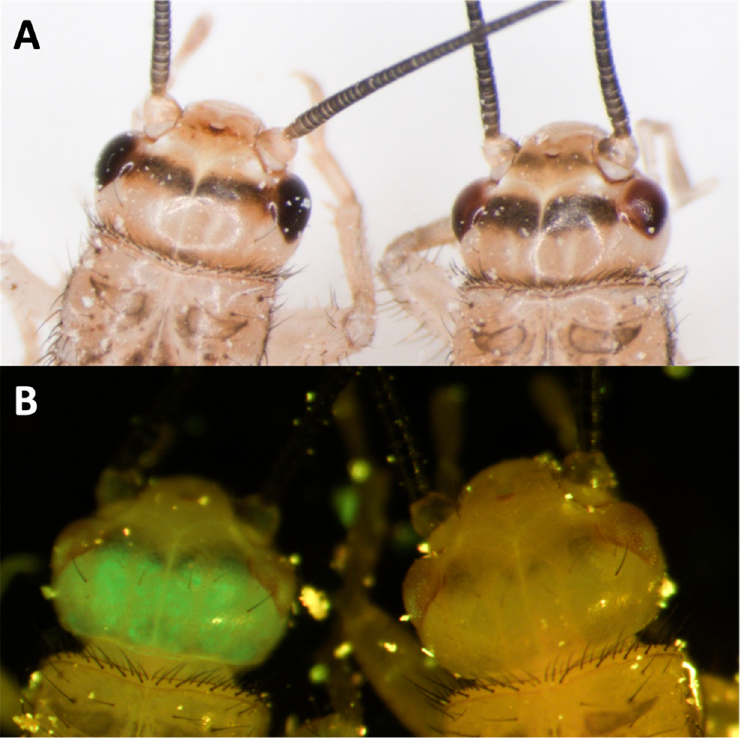
Figure 10. A. domesticus RNAi phenotypes. ( A ) Ad vermilion gene knock-down by RNAi in house cricket. Wild type eye color (left) compared with RNAi eye color (right). ( B ) GFP knock-down by RNAi in our EGFP expressing house cricket strain, AdVELV1-3. Regular EGFP expression (left) compared with dsEGFP RNAi cricket (right).